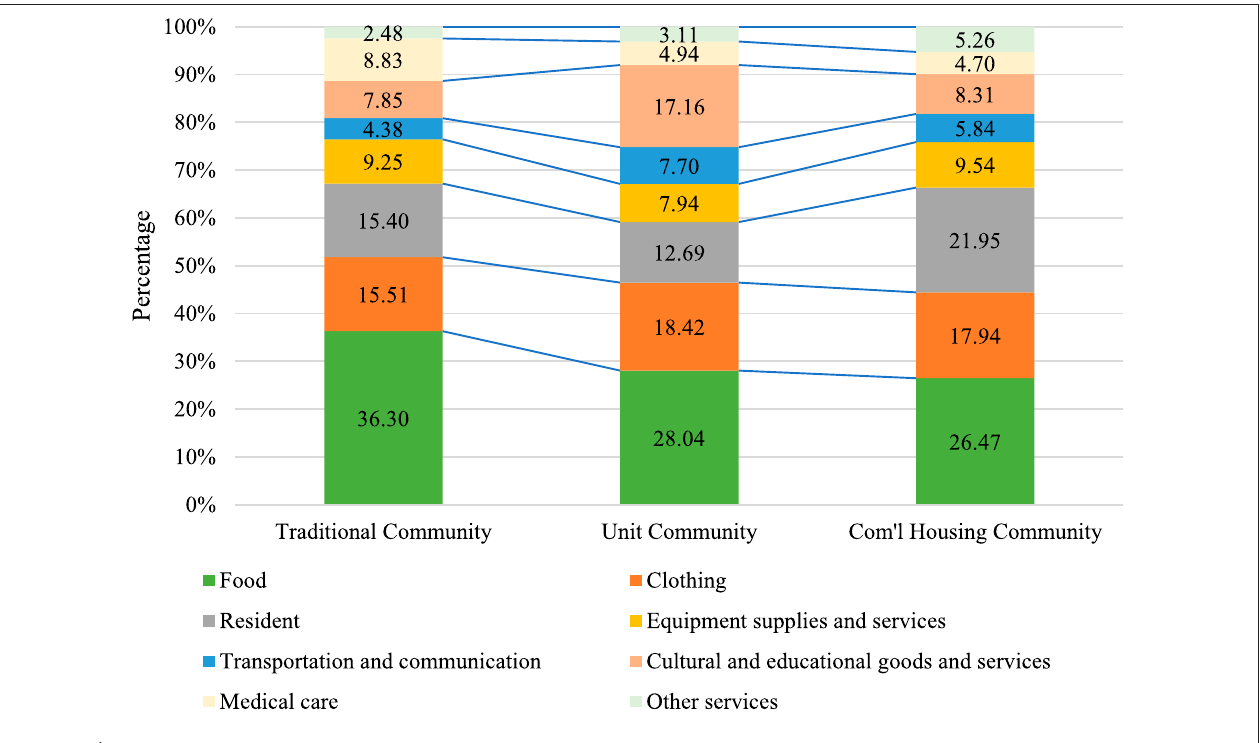
FIGURE 5 | Composition of indirect carbon emissions in three typical